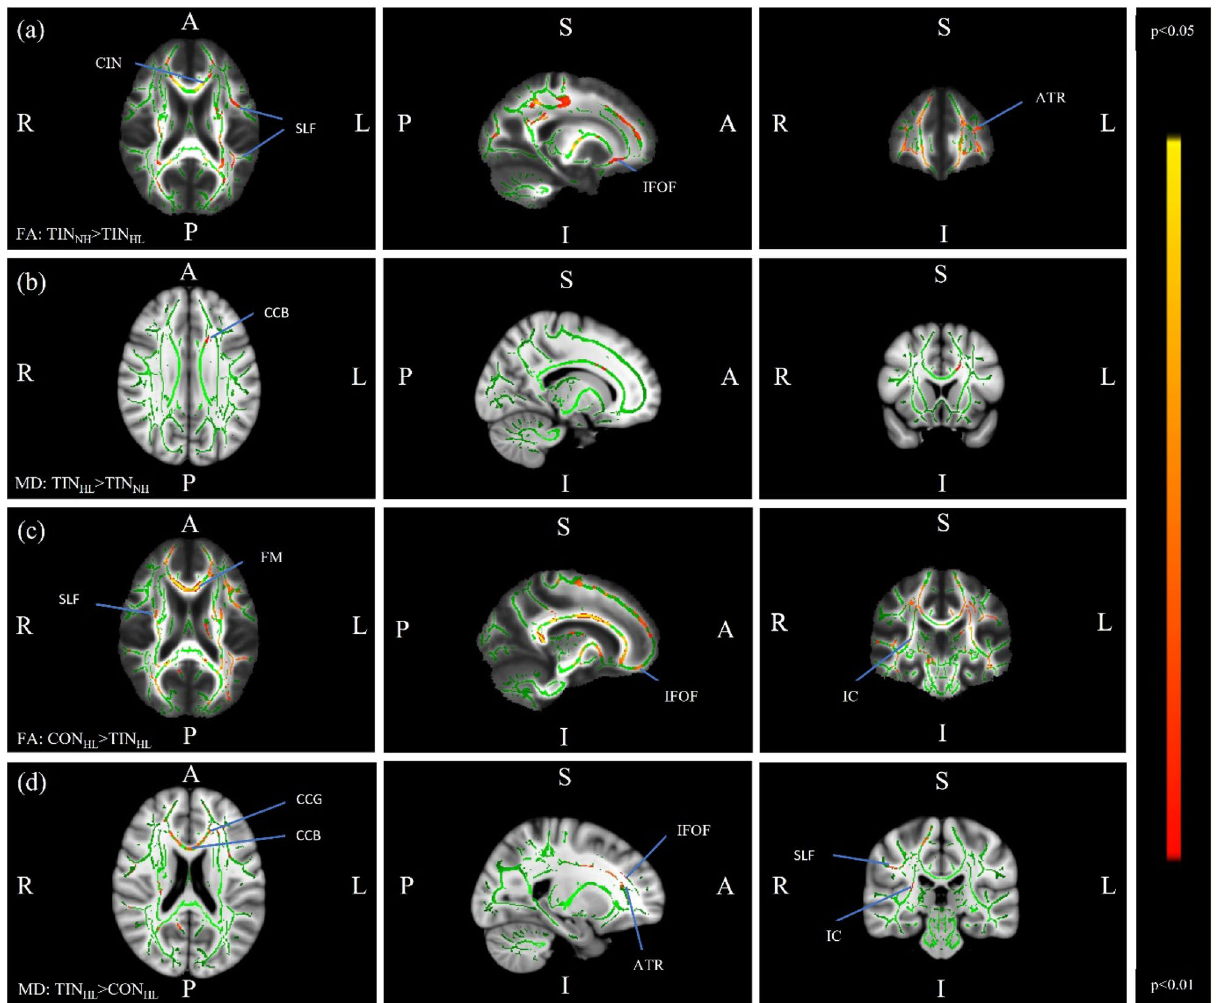
Figure 2. Regions of significant difference in subgroup-level FA and MD analyses (without age covariate). Green represents the mean FA of all participants. The red-yellow scale represents regions of significant difference, with red representing regions of greatest difference. Row ( a ) FA contrast for TIN NH > TIN HL , where regions of significant difference include the left cingulum (CIN), left inferior-fronto occipital fasciculus (IFOF), left superior longitudinal fasciculus (SLF), left anterior thalamic radiation (ATR). Row ( b ) MD contrast for